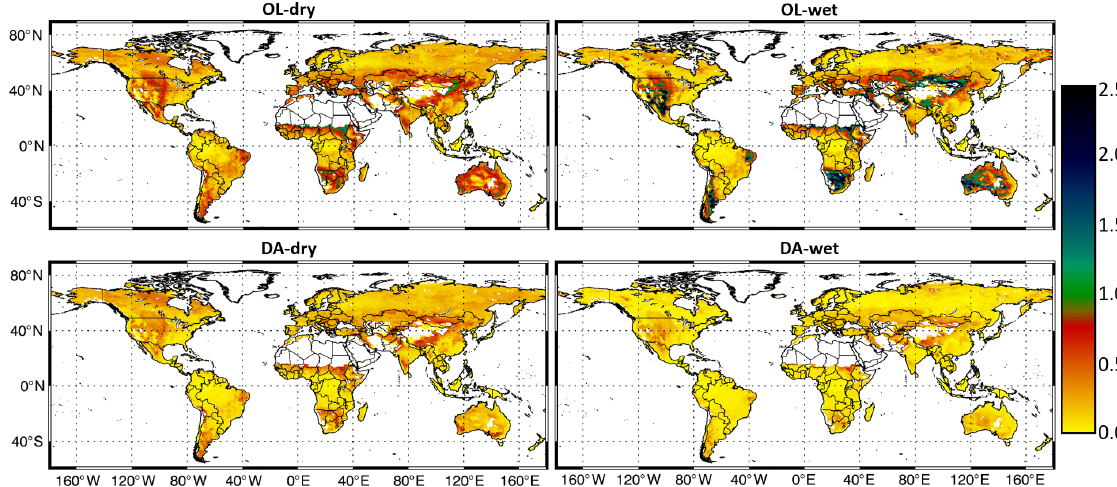
Figure 5. Maps of the LAI NCRMSE for the OL and DA runs.